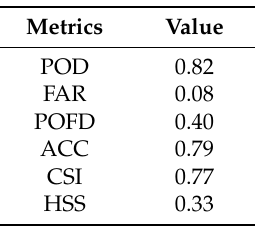
Table 10. Evaluation metrics of ground-based validation of S-2 binary snow maps in Turkey for winter season